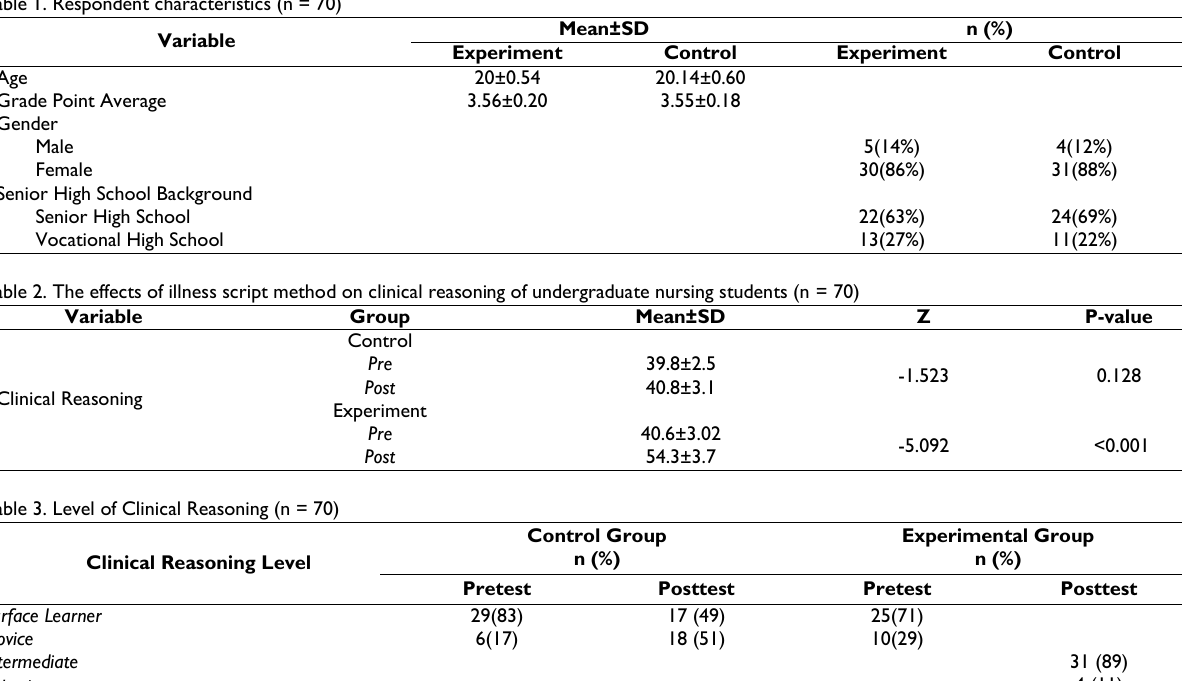
Table 1. Respondent characteristics (n = 70)